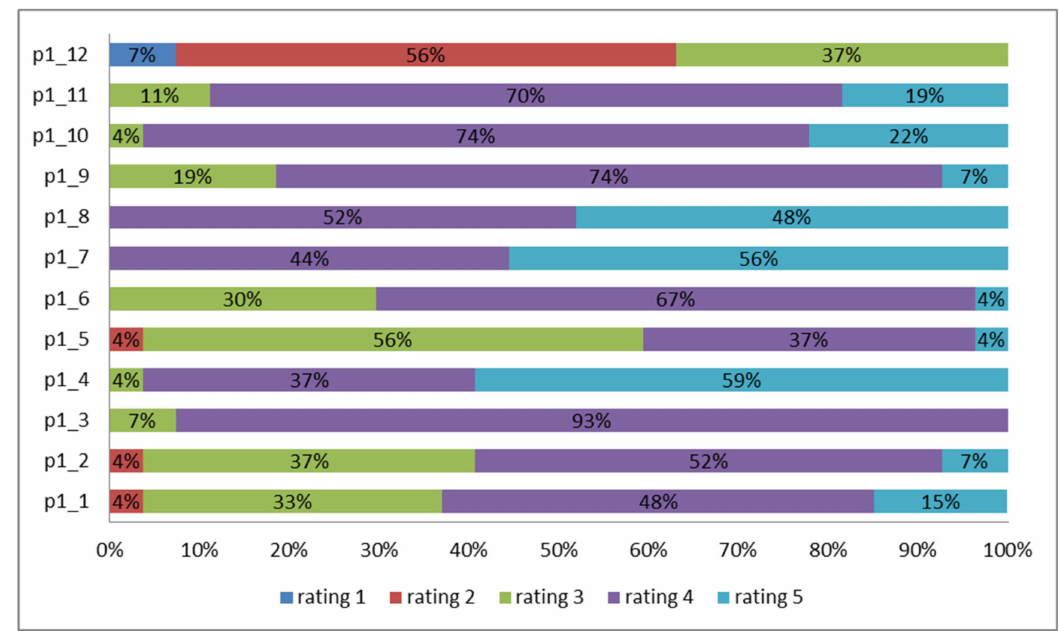
Figure 2. Assessment of the benefits (e ff ects) resulting from implementing CE in coal power